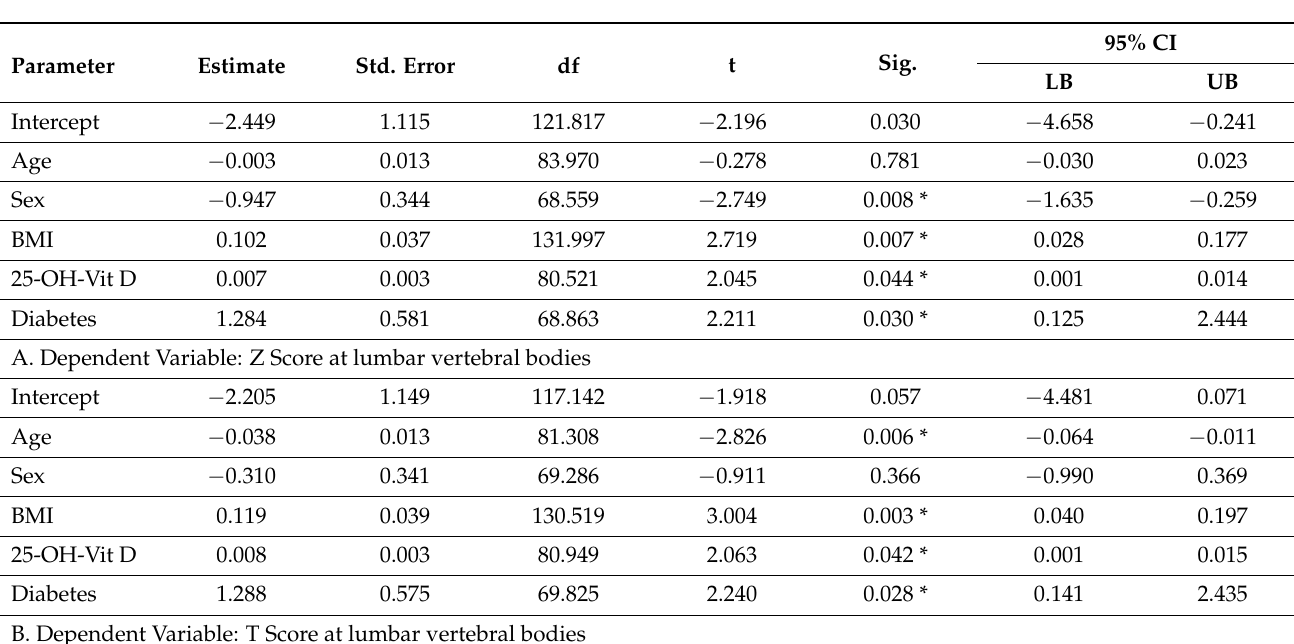
Table 5. Mixed model effect of inactive vitamin D on T-score and Z-score at lumbar vertebral bodies among kidney transplant patients not in treatment with active vitamin D and/or bisphosphonate and/or